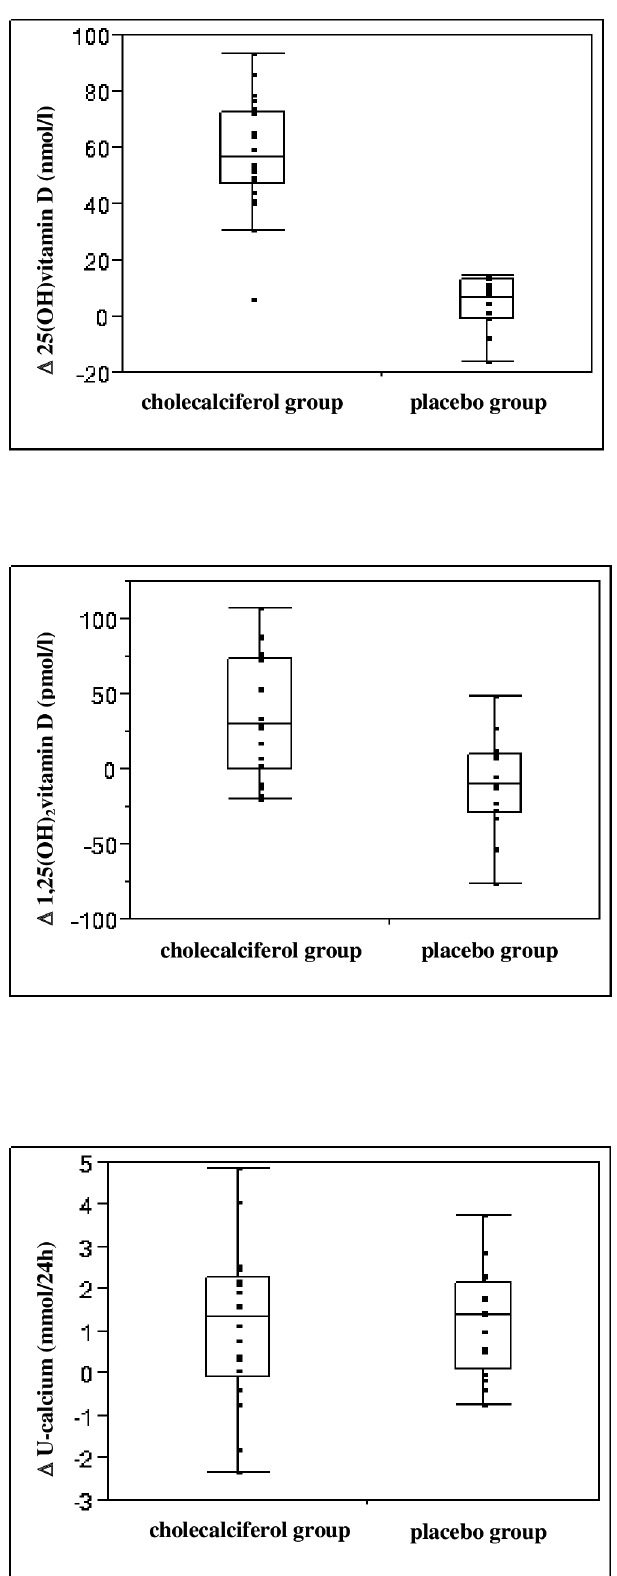
Figure 3. Box plots demonstrating changes in 25(OH)vitamin D, 1,25(OH) 2 vitamin D and urinary calcium excretion in the cholecalciferol group and placebo group during 16 weeks of treatment with cholecalciferol 3000 IU/day or placebo.